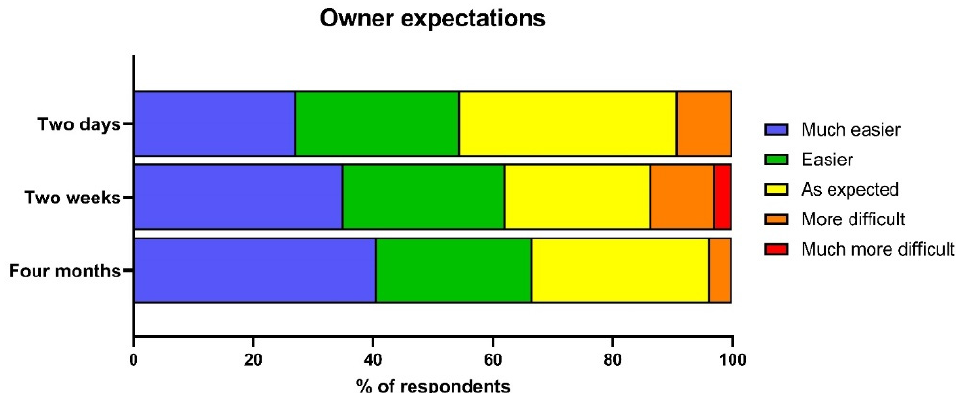
Figure 3. Owner expectations relative to their expectation of adoption at two days, two weeks, and four months post-adoption.